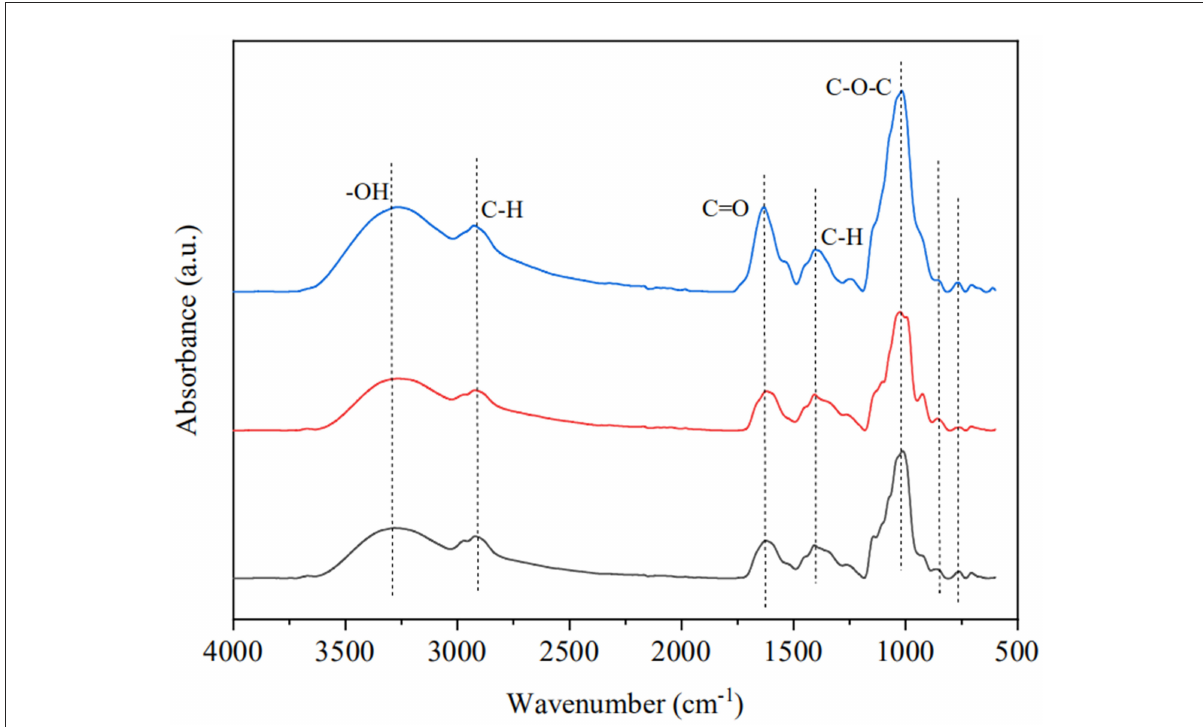
FIGURE2 Fourier transform infrared spectroscopy of GRP, GRP-1, and GRP-2. The black, red and blue curves represent the spectra of GRP, GRP-1, and GRP-2, respectively. GRP, ginsenosides-extracting residue polysaccharides; GRP-1 and GRP-2, fractions separated by 0M and 0.1M NaCl from GRP, respectively.